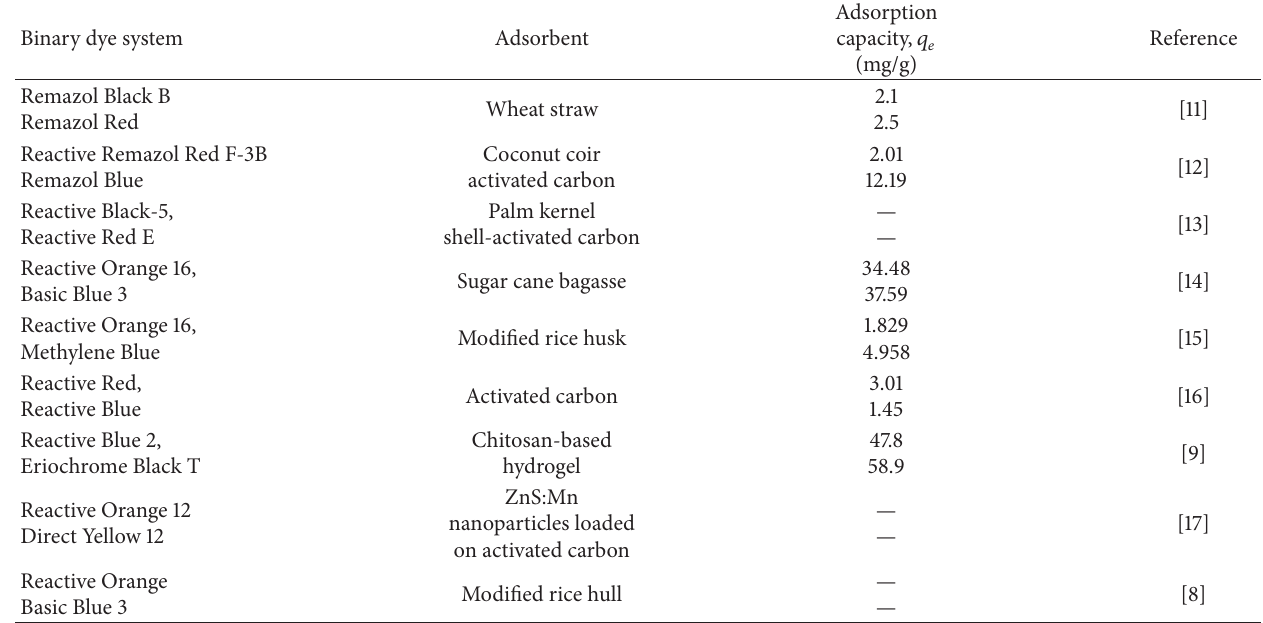
Table 1: Binary adsorption studies for the removal of reactive dyes from aqueous